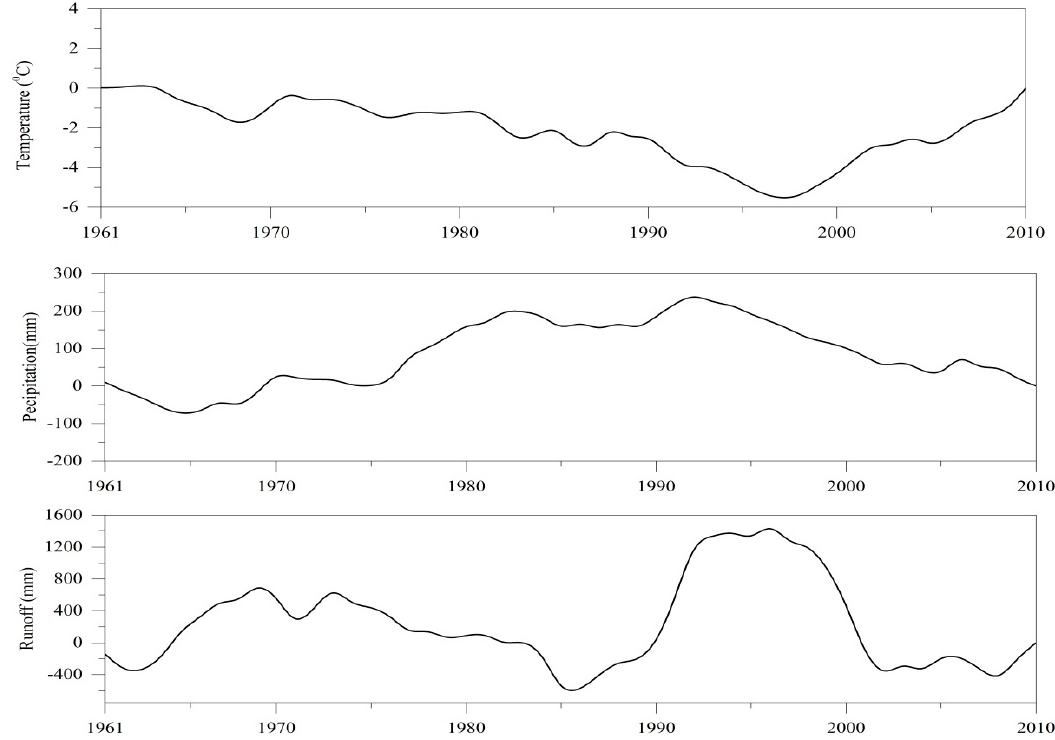
Figure 19. Accumulative deviation curve for runoff, precipitation and temperature for Zone II.